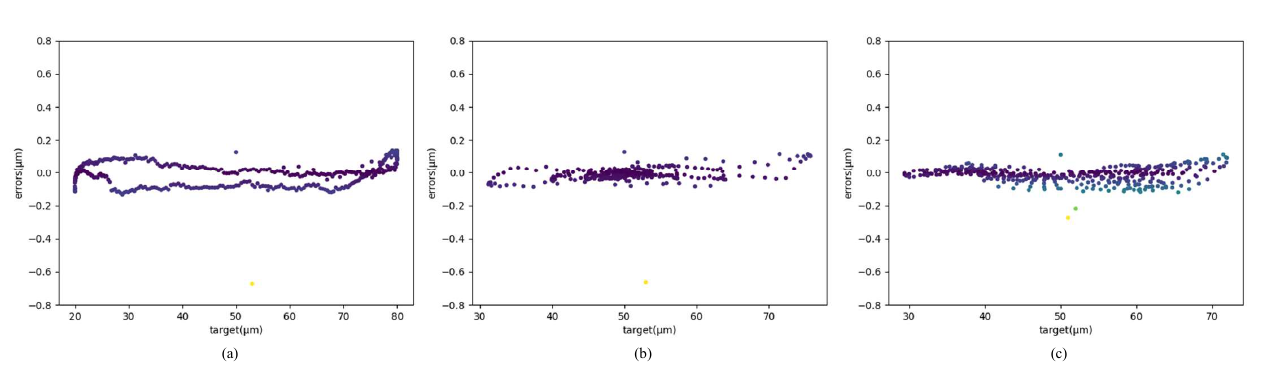
Figure 1. Control flaws of MLP. ( a ) Sinusoidal error distribution. ( b ) Dampened sinusoidal error distribution. ( c ) Amplified sinusoidal error